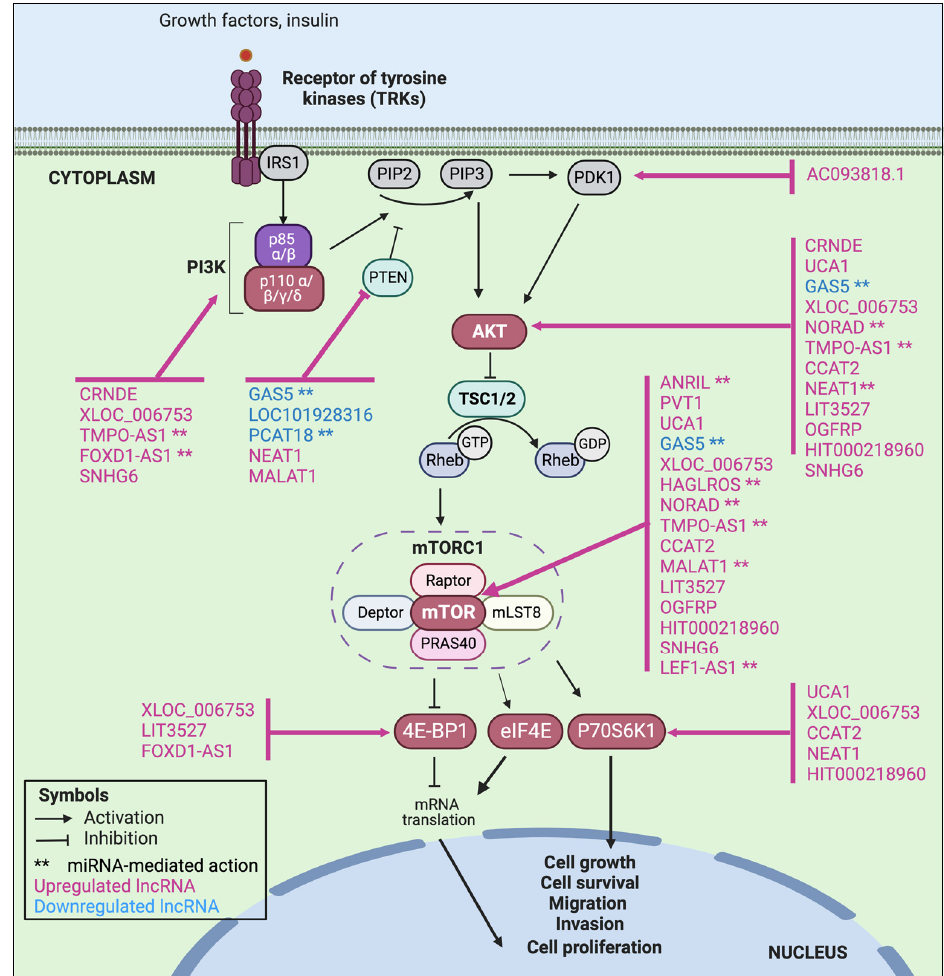
Figure 3. The PI3K/AKT/mTOR pathway and its current model of regulation by lncRNAs.